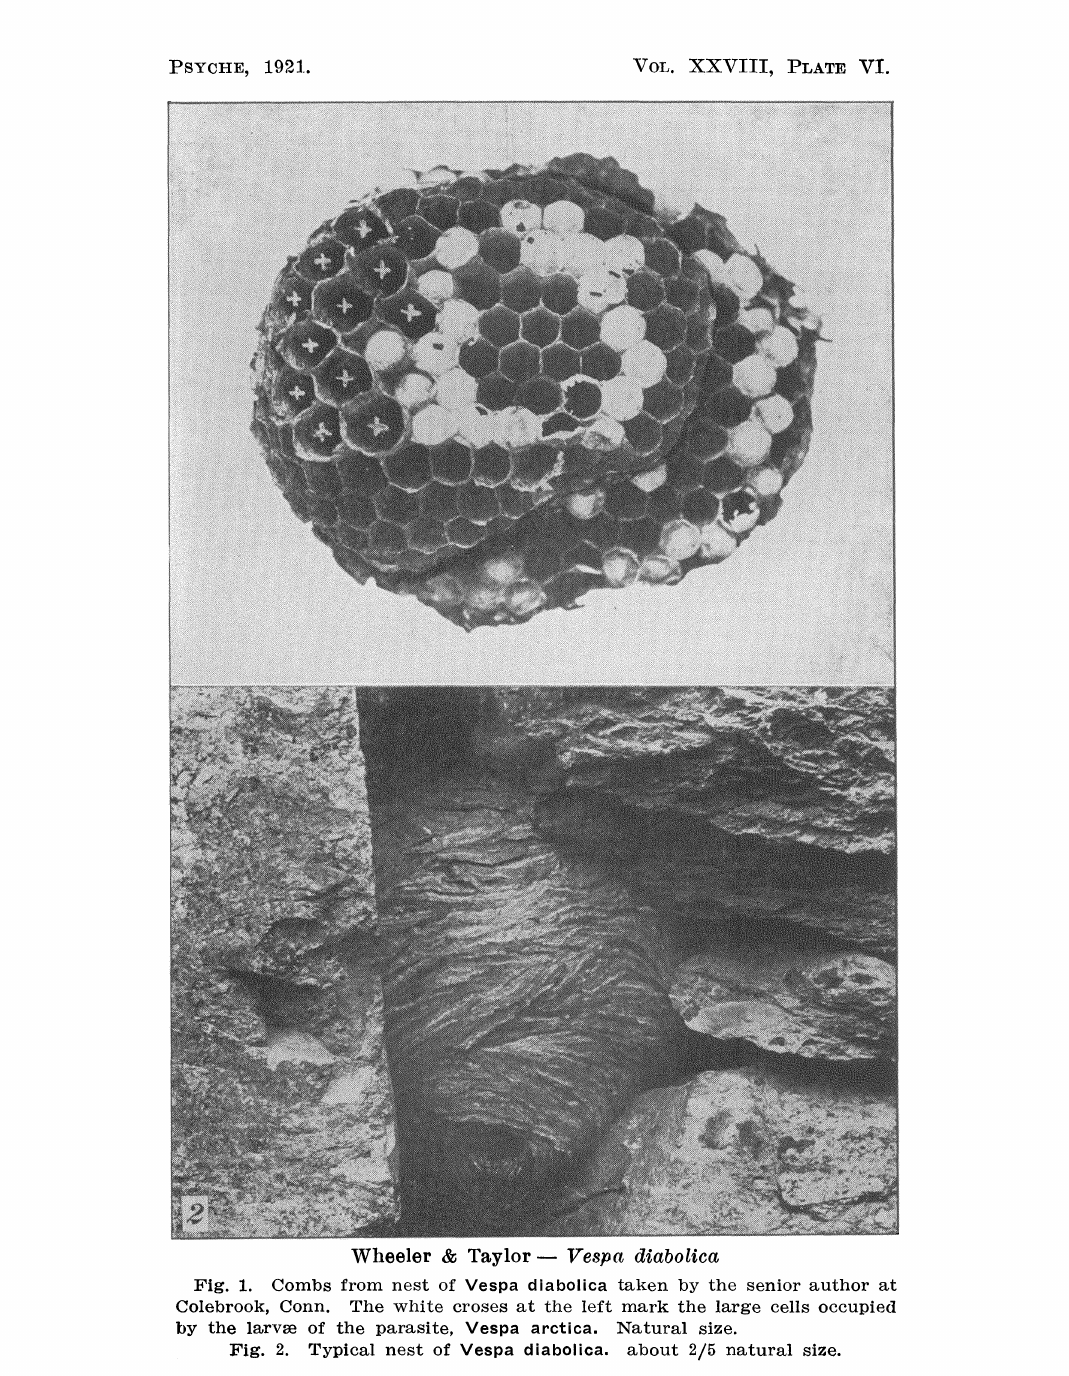
Fig. 1. Combs from nest of Vespa diabolica taken by the senior author at Colebrook, Conn. The white croses at the left mark the large cells occupied by the lrvse of the parasite, Vespa arctica. Natural size. Fig. 2. Typical nest of Vespa diabolica, about 2/5 natural